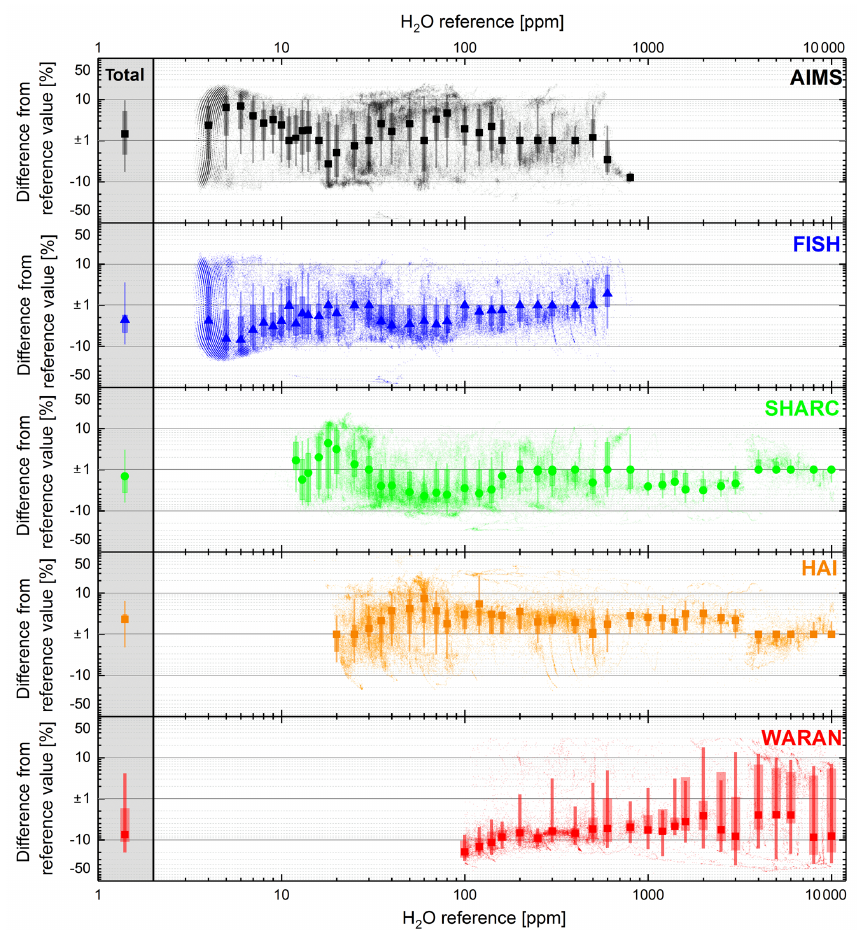
Figure 4. Relative difference of the measurements of AIMS, FISH, SHARC, HAI and WARAN from the mean H 2 O molar mixing ratio value which is used as a reference (details see text). The small dots are the single measurement points (1Hz values). The big squares, triangle and circle are mean values of the relative difference for specific bins of H 2 O mixing ratio. The broad bars represent the 25th–75th percentile, while the narrow bars stand for the 10th–90th percentile within the bins. All points with a deviation between − 1% and + 1% fall on the ± 1 line. Values in the gray box on the left-hand side represent the overall mean values for the different